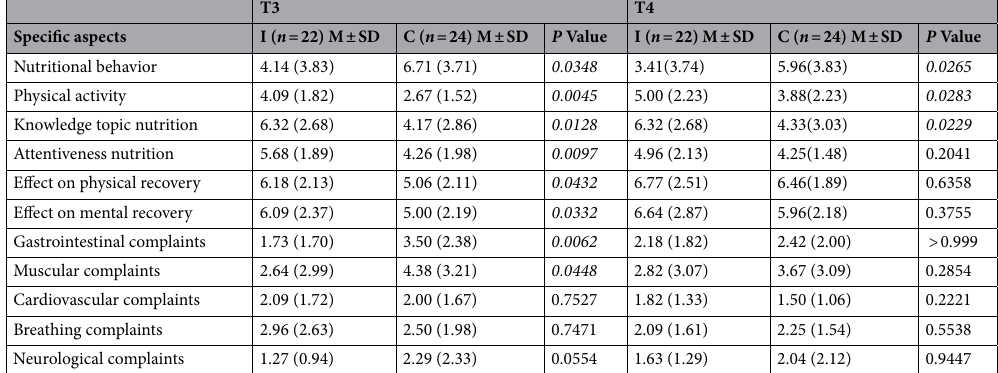
Table 3. Patient-specific aspects at measurement times T3 (3 months postop.) and T4 (6 months postop). Significant values are in italics. M = mean, SD = standard deviation, I = intervention group, C = control